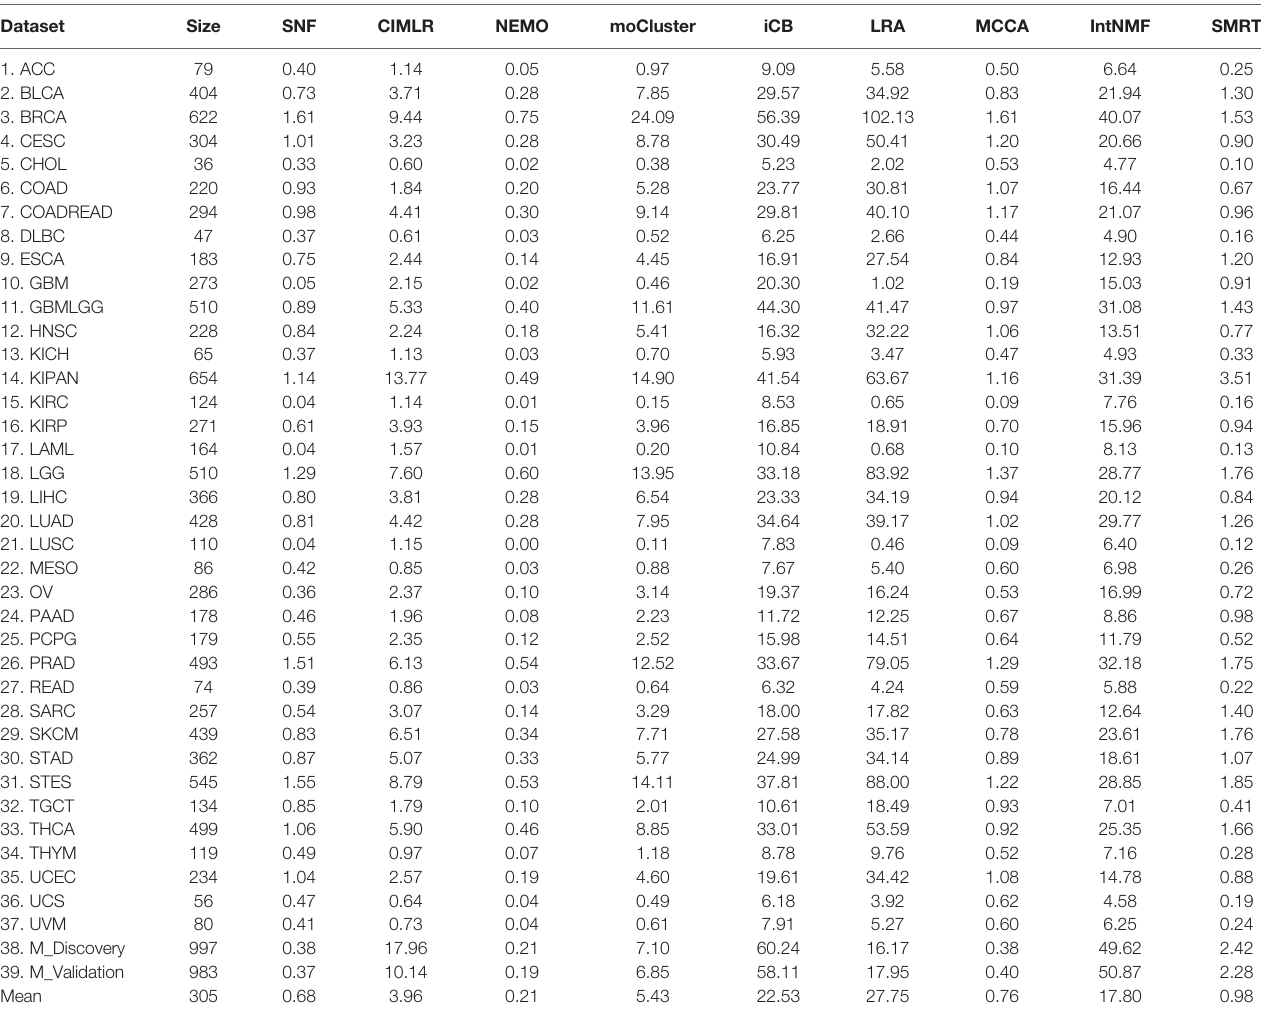
TABLE 2 | Running time (in minutes) of SNF, CIMLR, NEMO, moCluster, iClusterBayes (iCB), LRACluster (LRA), MCCA, IntNMF, and SMRT for 37 TCGA and two METABRIC datasets.